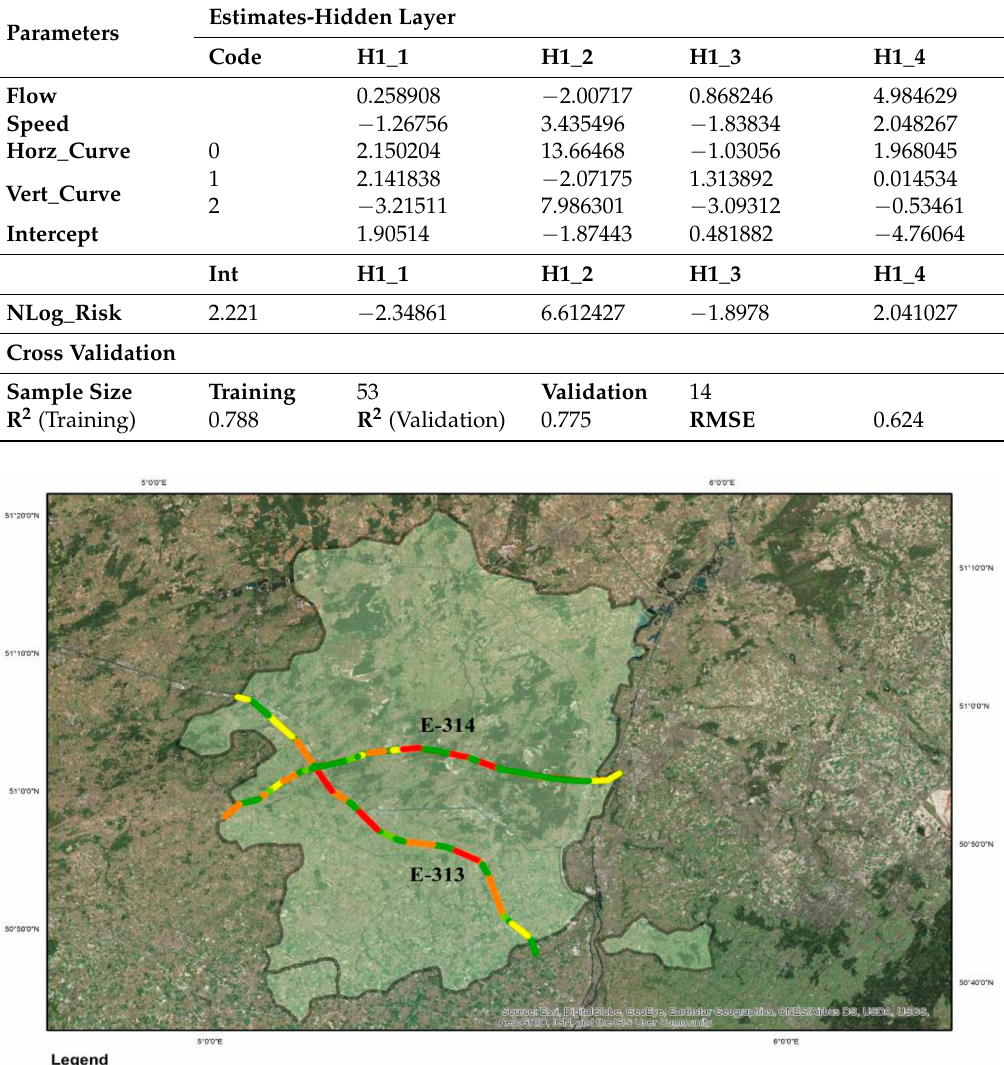
Table 4. Parametric estimates of the ANNs Model.